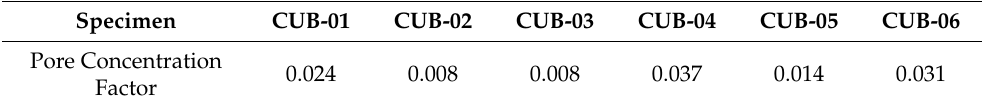
Table 2. Pore concentration factors.